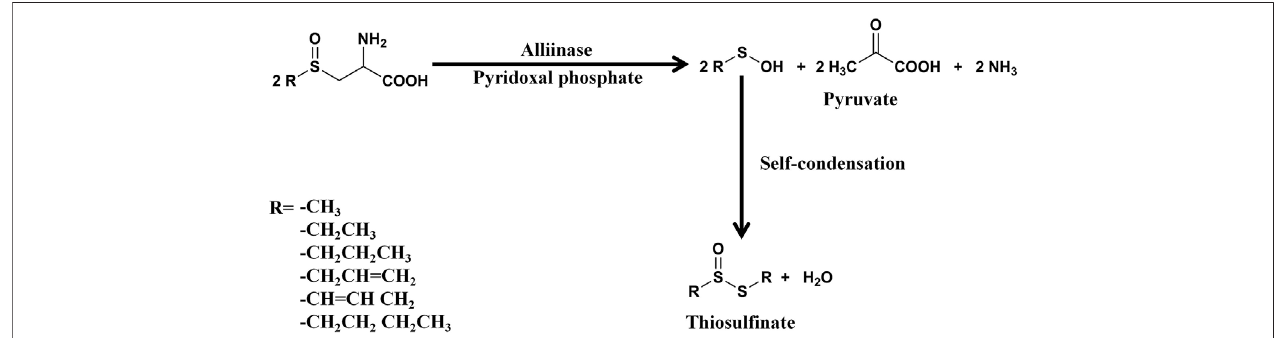
FIGURE 1 | The synthesis process of thiosul fi nates. One molecule of thiosul fi nate is synthesized from two molecules of sulfenic acids, and the fi gure shows the different R groups of thiosul fi nates (Rose et al., 2005).